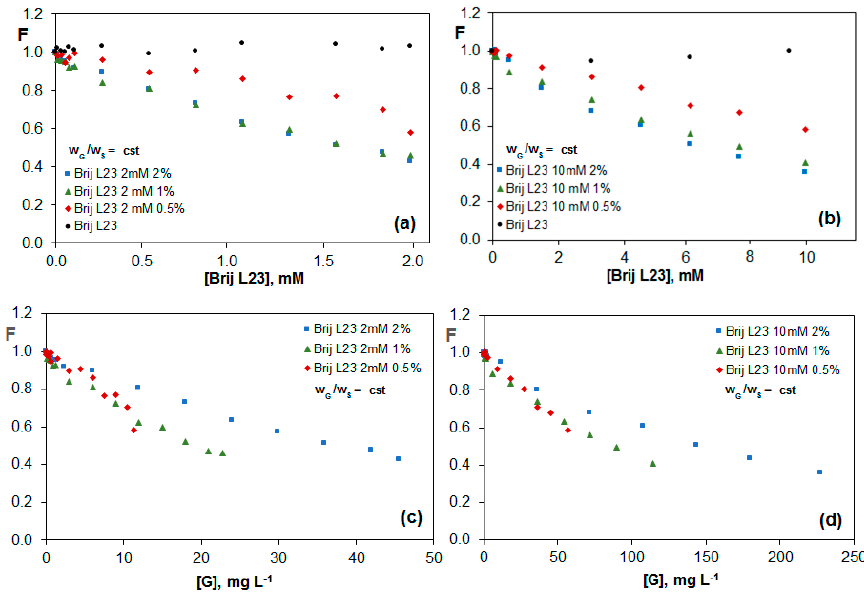
Figure 4. Change in the fluorescence of vitamin B 2 (F) for G dispersions in 2 mM ( a , c ) and 10 mM ( b , d ) Brij L23 as a function of surfactant concentration ( a , b ) or graphene concentration ( c , d ) for solutions with a constant G/surfactant weight ratio.